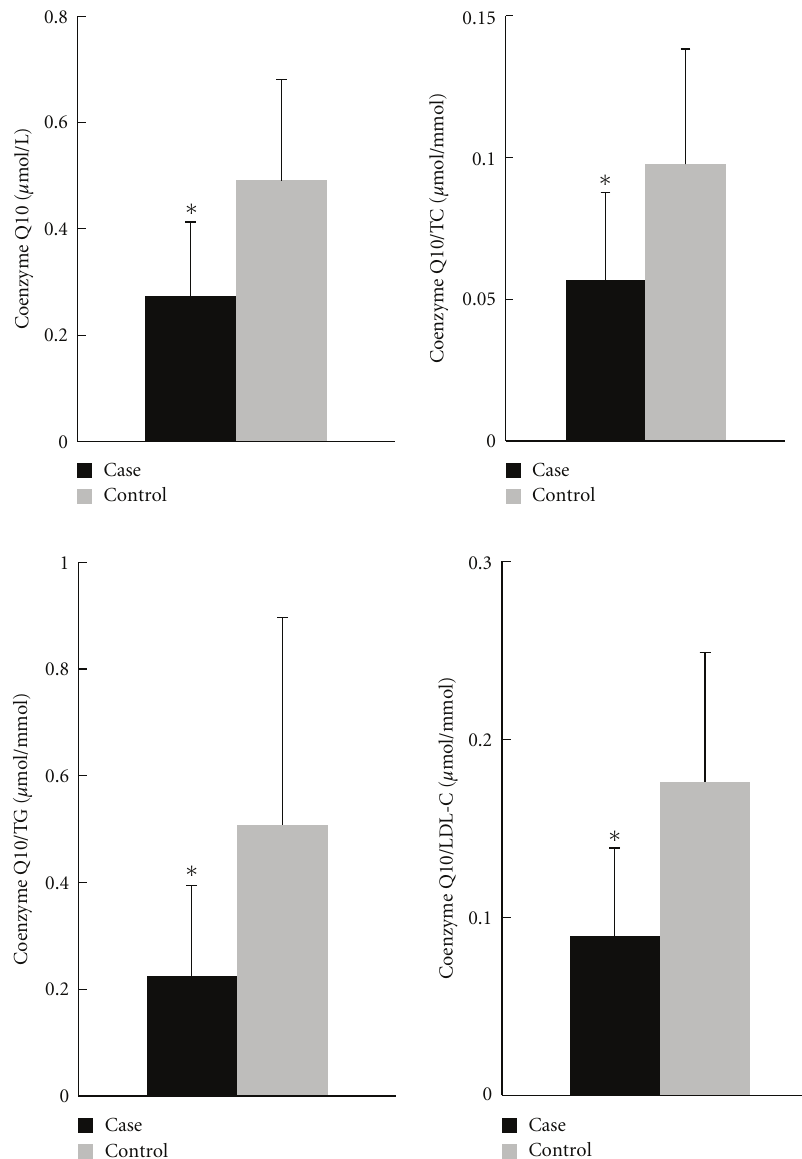
Figure 1: Concentrations of plasma coenzyme Q10 and the ratios of coenzyme Q10 to lipid profiles. ∗ Values were significantly di ff erent between case and control groups; P < 0 . 01. LDL-C: low density lipoprotein-cholesterol; TC: total cholesterol; TG: